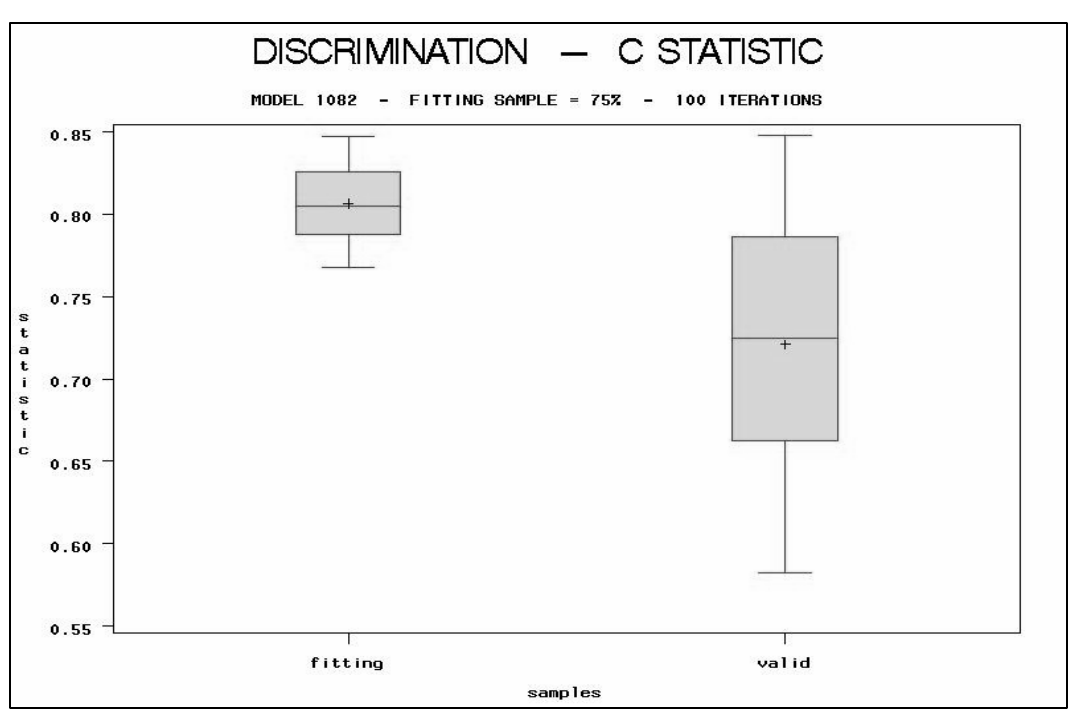
Figure 4 – Discrimination: fitting versus validation